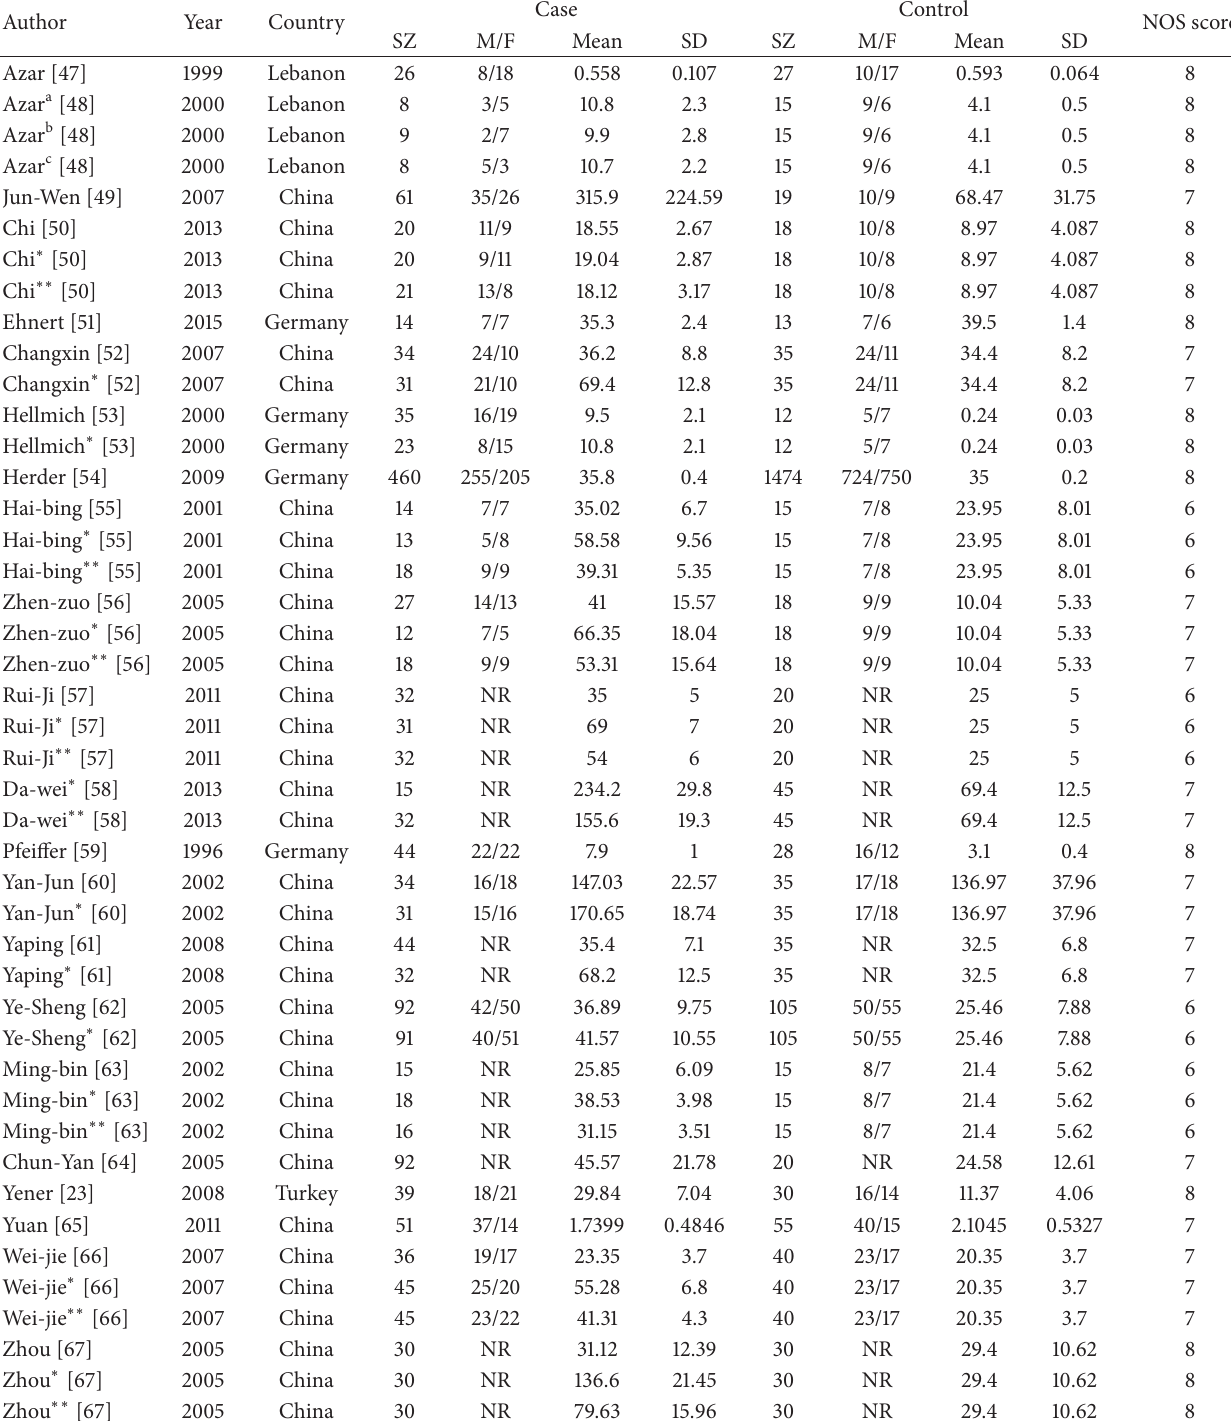
Table 2: Characteristics of studies about TGF- 𝛽 ( 𝜇 g/L) included in this